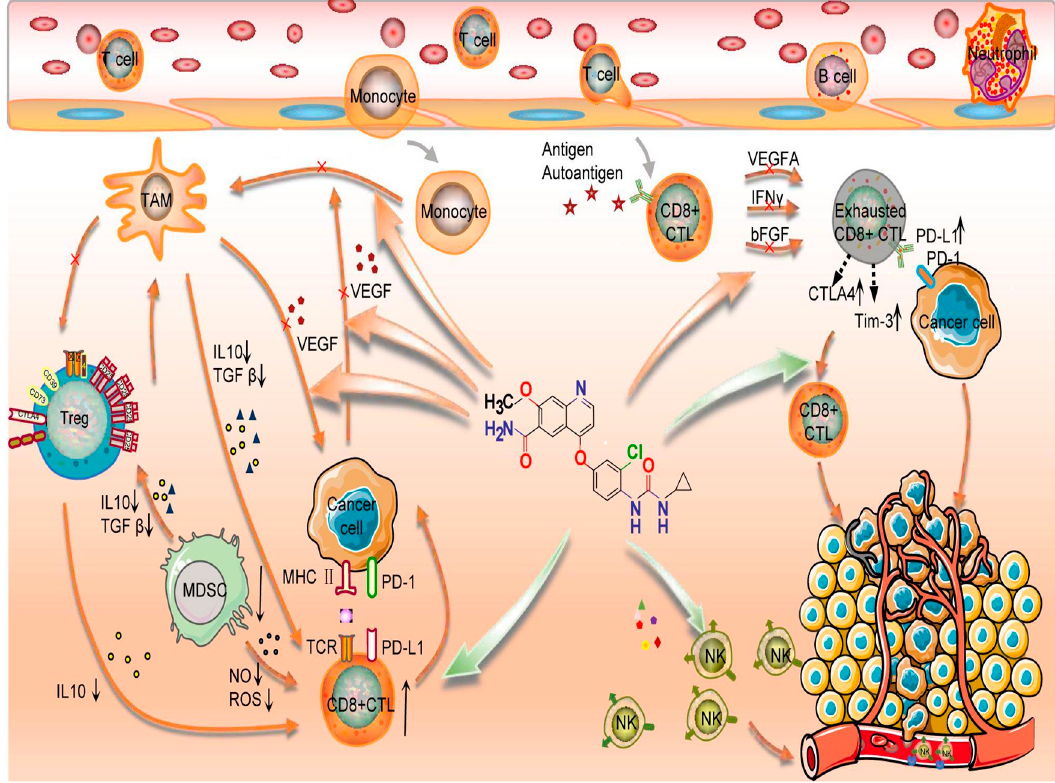
Figure 1. Lenvatinib’s action mode when combined with immunological check point inhibitors.